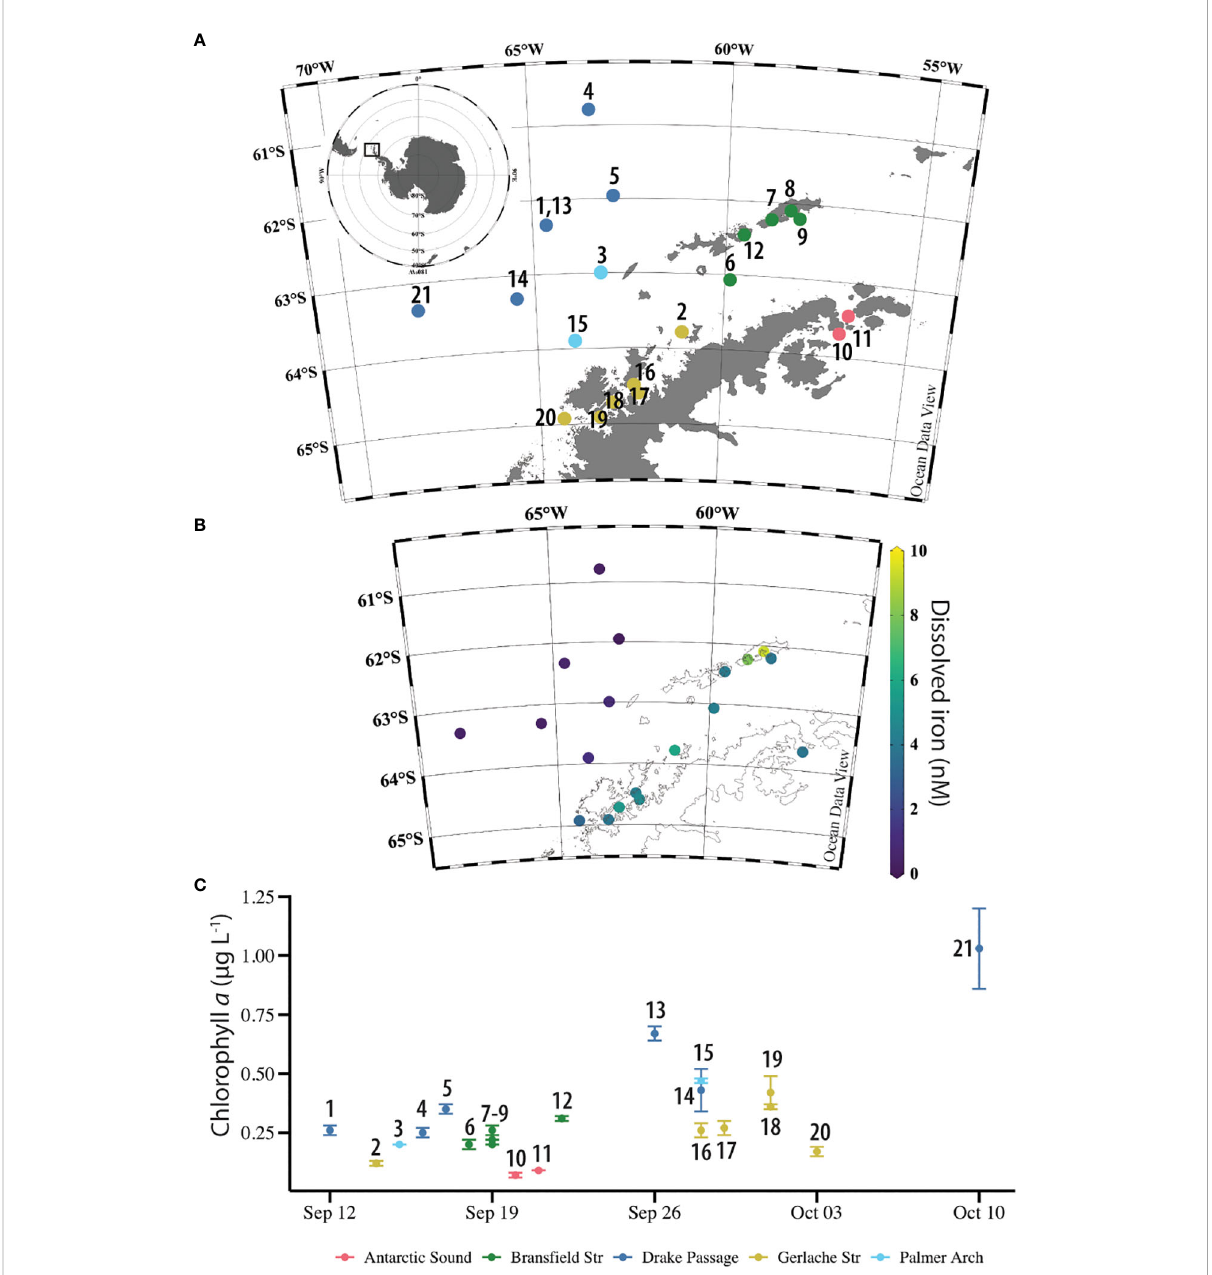
FIGURE 1 Overview of the sampling location and context of the NBP16-08 stations. (A) Location of 21 stations near the West Antarctic Peninsula. Stations 1 and 13 were the same location, sampled 14-days apart. Stations are labeled with station number and colored by their general location: Drake Passage (dark blue), Palmer Arch (light blue), Brans fi eld Strait (green), Gerlache Strait (gold), and Antarctic Sound (pink). Plot made in Ocean Data View (Schlitzer 2021). (B) Concentration of dissolved iron (nM) in surface seawater at NBP16-08 stations. There were no surface dissolved iron samples from Station 11. Plot made in Ocean Data View (Schlitzer 2021). (C) Concentration of chlorophyll a (µg L -1 ) in surface seawater samples at NBP16-08 stations across time and labeled with station number. Stations 10 and 11 were sampled at 25 m. Error bars are the standard deviation of n = 3 replicate averages, except for Station 1 with n = 2. Stations are labeled with station number and colored by their general location: Drake Passage (dark blue), Palmer Arch (light blue), Brans fi eld Strait (green), Gerlache Strait (gold), and Antarctic Sound